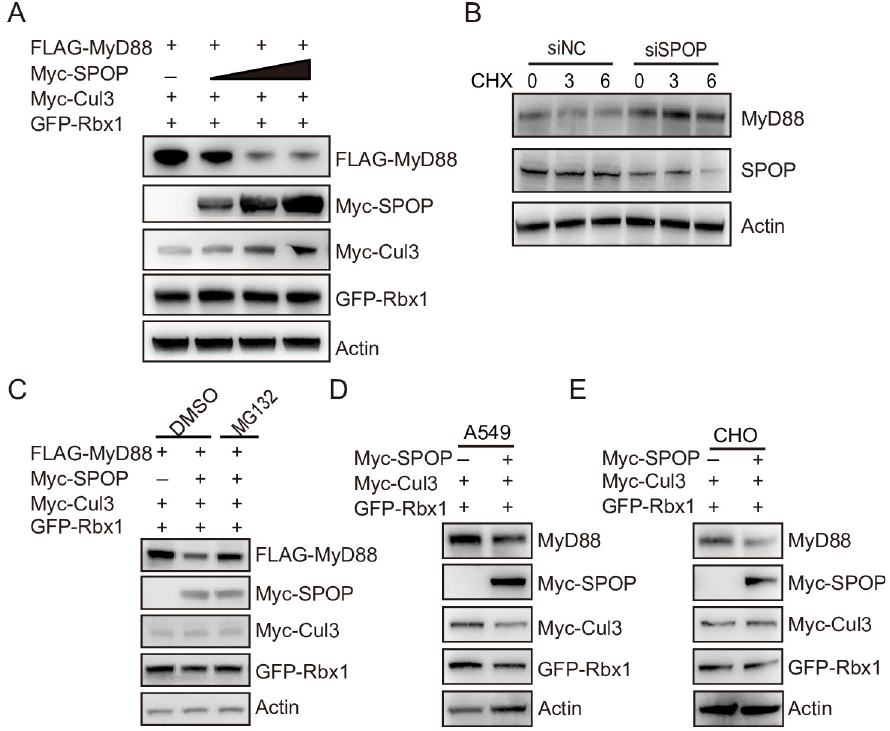
Fig 2. ChSPOP promotes proteasomal degradation of chMyD88. (A) Immunoblot analysis of chMyD88 in cell lysates of chicken DF1 cells transfected with chCul3, chRbx1 and increasing doses of Myc-tagged chSPOP (0, 0.4, 0.8, 1.6 μ g). (B) Immunoblot analysis of endogenous chMyD88 in cells having chSpop inhibited by siRNA. Cells were treated with 50 μ g/ml CHX for 0, 3, or 6 hours. (C) Immunoblot analysis of chMyD88 in cell lysates of chicken DF1 cells transfected with chSPOP and treated with DMSO or 20 μ M MG132 for 6 hours. (D) and (E) Immunoblot of human MyD88 in A549 cells and mouse MyD88 in mouse CHO cells transfected with Myc-SPOP.